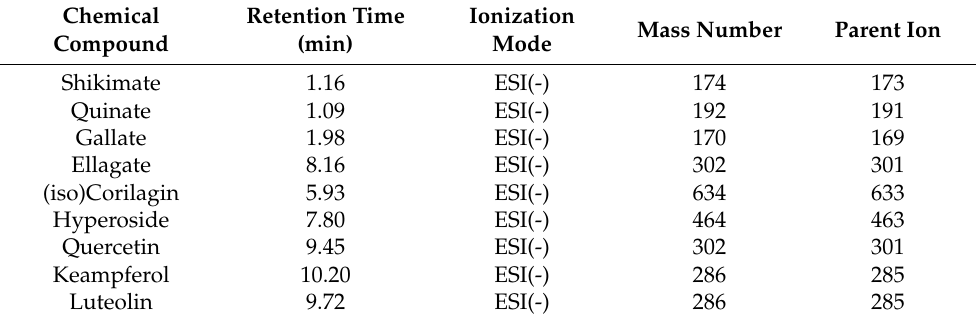
Table A1. Quantitative parameters of shikimate, quinate and phenolic compounds’ determination in Chinese olive fruit by mass spectrometry MRM.